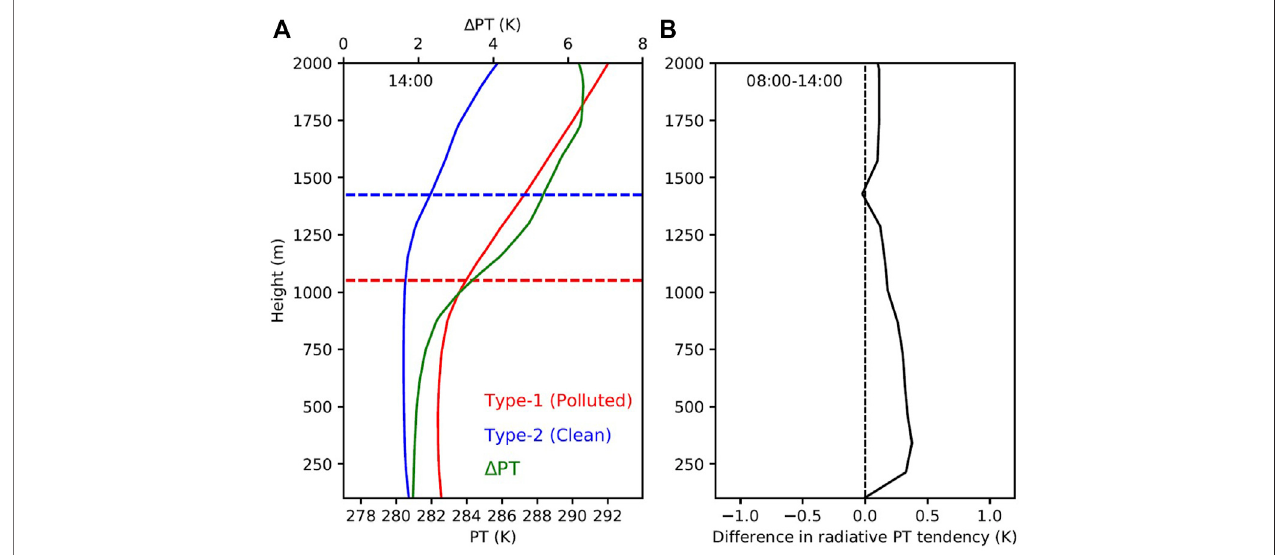
FIGURE 4 | (A) Averaged PT pro fi les at 14:00 LT in Wuhan on the polluted (in red) and clean (in blue) days under the typical synoptic types and their difference (in green),and (B) thedifferenceinthePTtendencyduetoradiationbetweenthepollutedandcleandaysfrom08:00to14:00LT.AllthePTpro fi lesshownarederivedfrom MERRA-2, and the BLHs at 14:00 LT were denoted by the dashed lines in (A) .